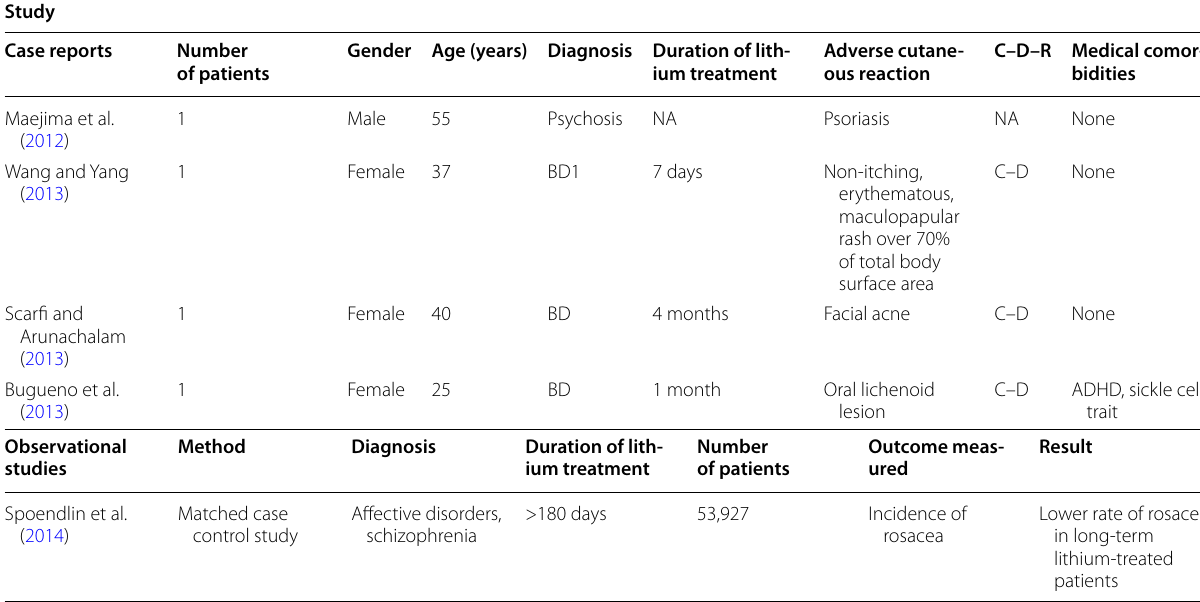
BD bipolar disorder, BD1 bipolar disorder type 1, NA : not available, C–D–R challenge–de-challenge–re-challenge, C–D challenge–de-challenge